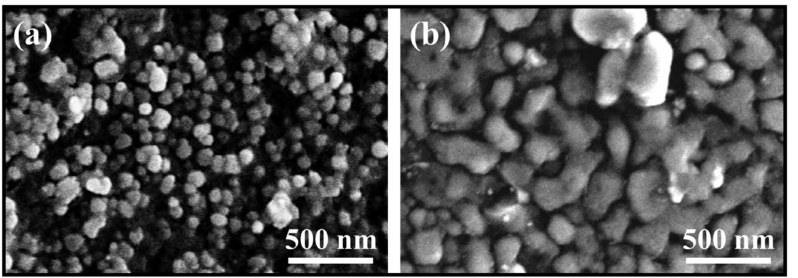
Figure 12. Morphologies of compounds on diamond surface: ( a ) granular structure, ( b ) island structure. Reprinted with permission from Ref. [58]. Copyright 2016, Elsevier.